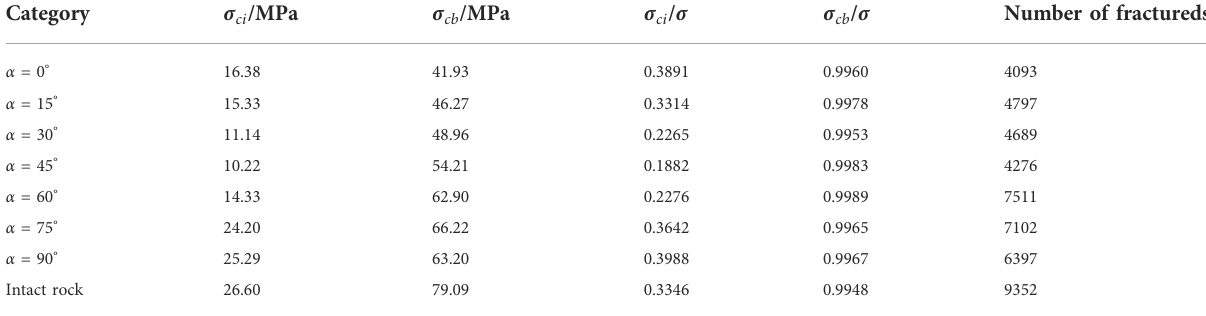
TABLE 2 Relationship between initiation stress, damage stress, fracture number, and uniaxial compressive strength of the rock model. Category